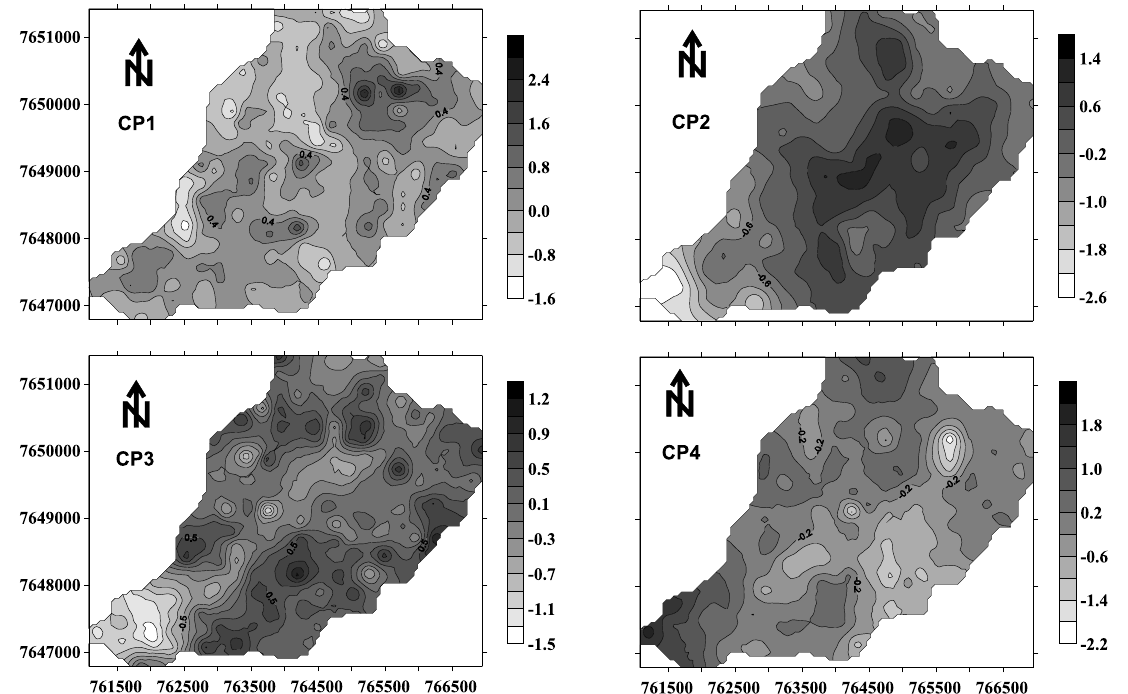
Figura 4. Distribuição espacial dos componentes principais ao longo do relevo (CP1: componente principal 1; CP2: componente principal 2; CP3: componente principal 3; CP4: componente principal 4) (Datum: UTM 22K Córrego Alegre